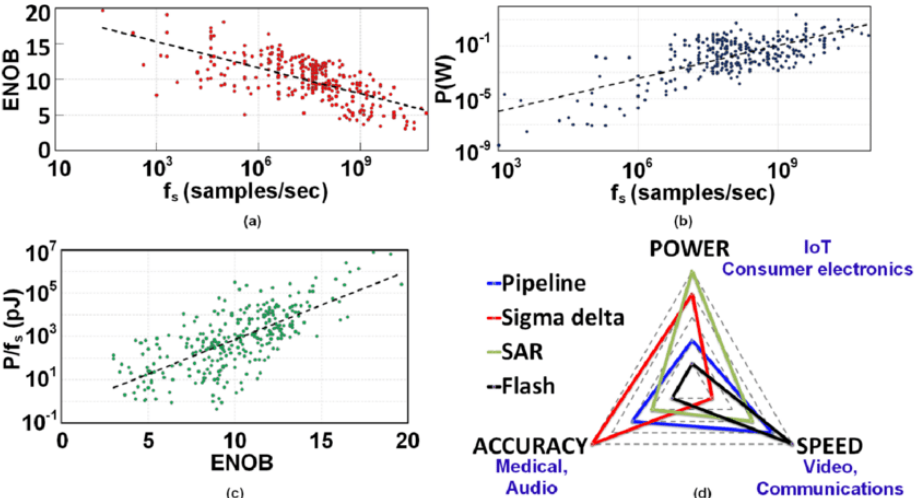
Figure 4. The analog-to-digital converter is one of the units encompassing the sensors. Its design accounts for various trade-offs which ultimately impact generated measurements and performances. Trade-offs in conventional analog-to-digital converter architectures between ( a ) speed and accuracy, ( b ) speed and power, and ( c ) accuracy and energy, as reported in [51]. ( d ) Spider diagram of analog- to-digital architectures (different color lines), design trade-off, and associated applications (in blue). From